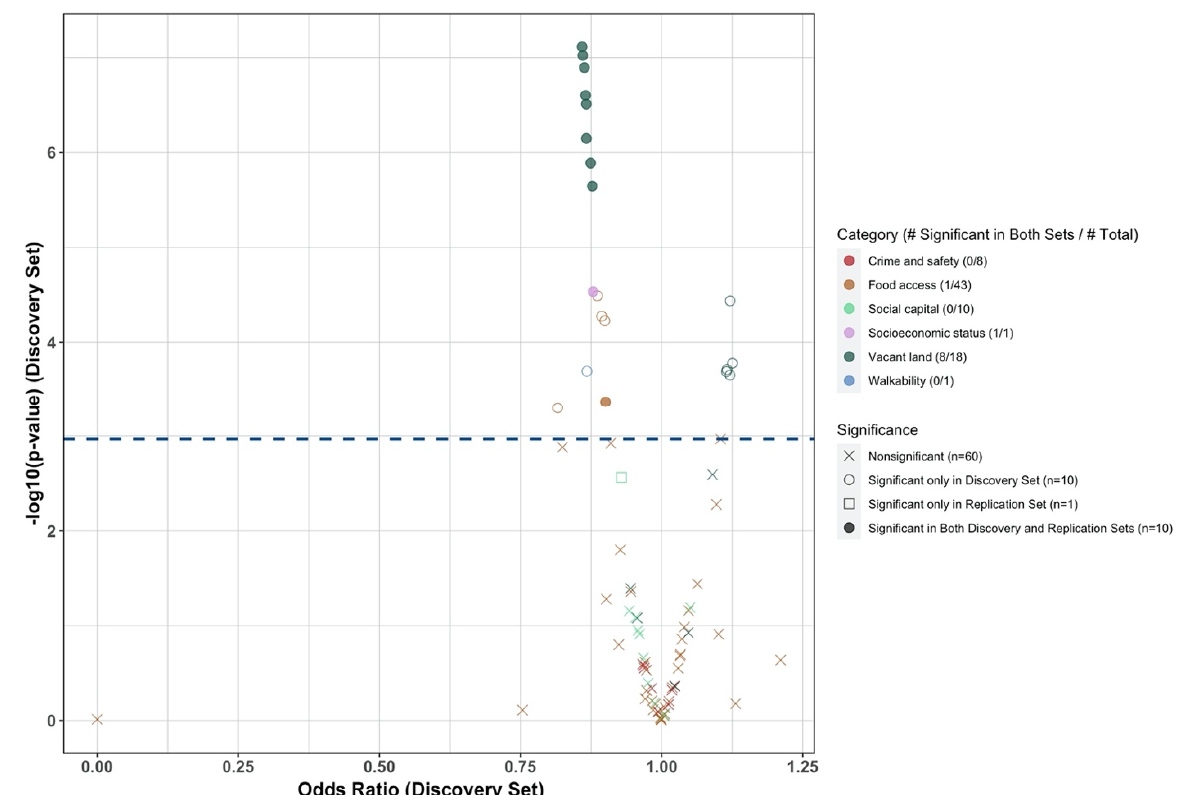
Figure 1. Volcano plot of the results from phase 1 of the two-phase approach.